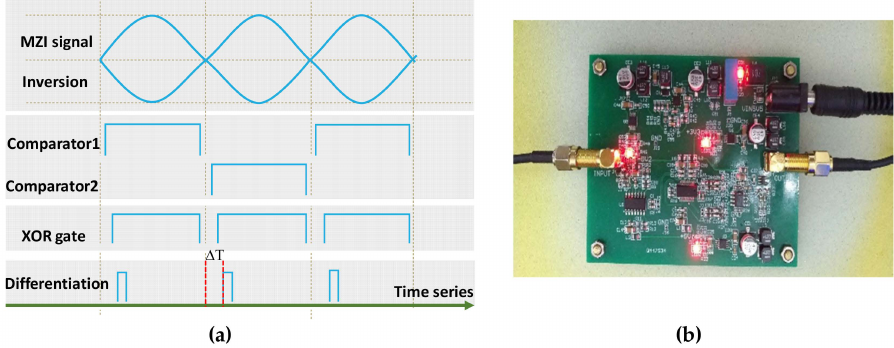
Figure 2. ( a ) Time-series analysis for each node on the circuit; ( b ) photograph of the circuit board based on the proposed zero-crossing detection scheme.